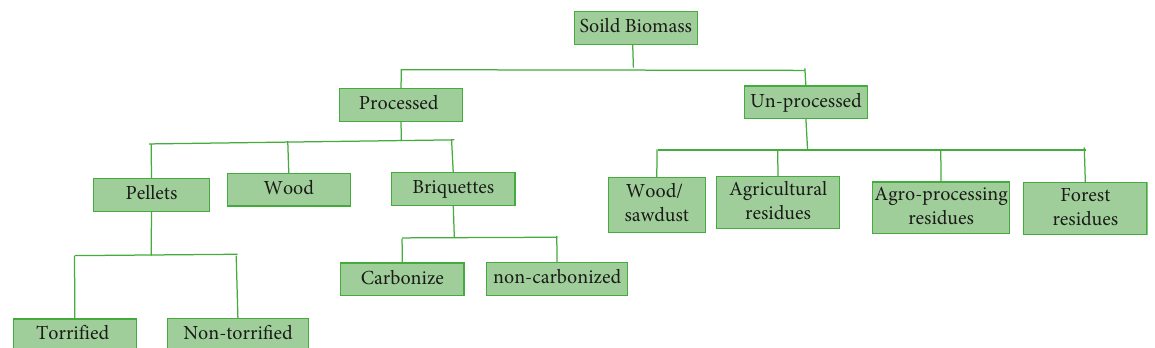
Figure 2: Classification of solid biomass